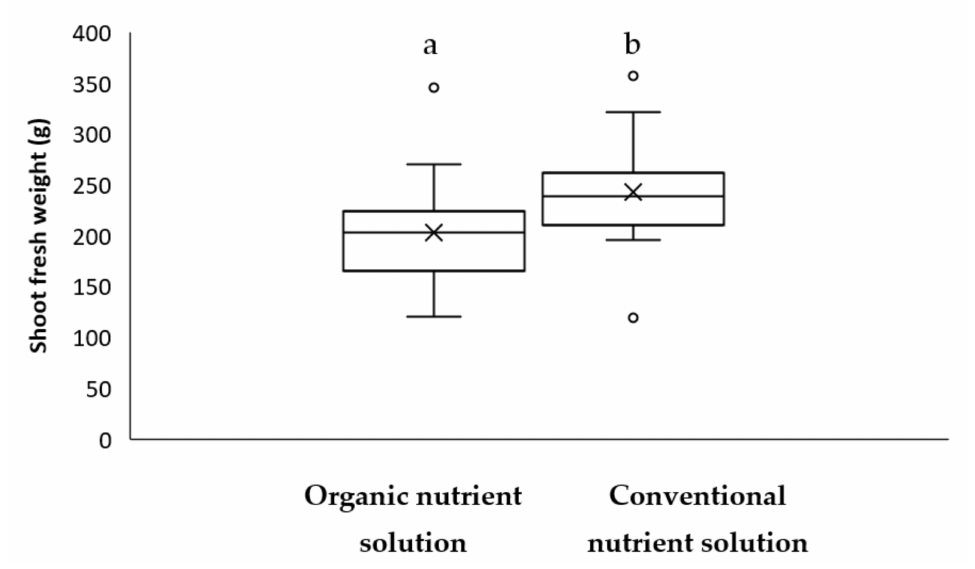
Figure 4. Shoot fresh weight of lettuce grown in organic nutrient solution and in conventional mineral nutrient solution. Different letters indicate statistically significant